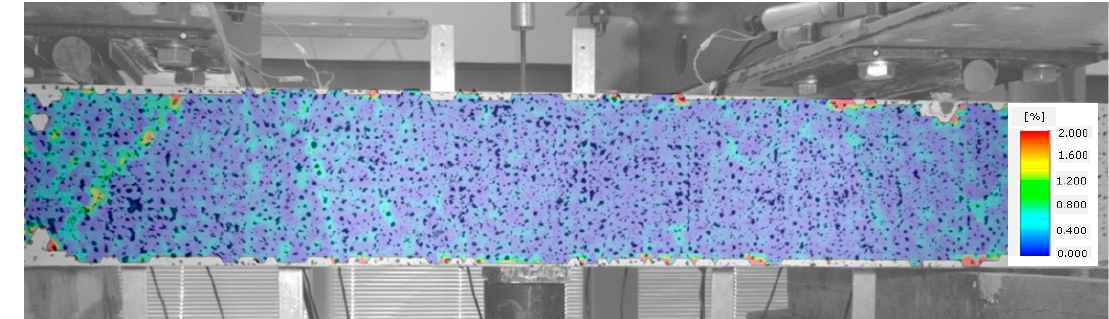
Figure 9. Stage I of shear behavior of element—no cracks.